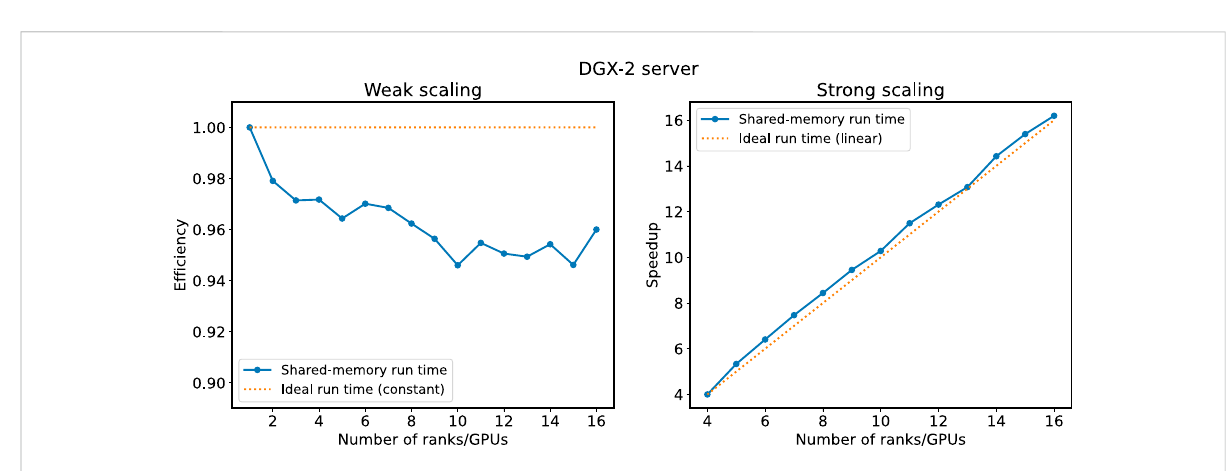
FIGURE 7 Results from scaling experiments on DGX-2 shared-memory system. Weak scaling (1 – 16 GPUs) is shown in the left panel and strong scaling (4 – 16 GPUs) is shown in the right panel. Run times are normalized with respect to the single rank/GPU experiment for weak scaling and the four ranks/GPUs experiment for strong